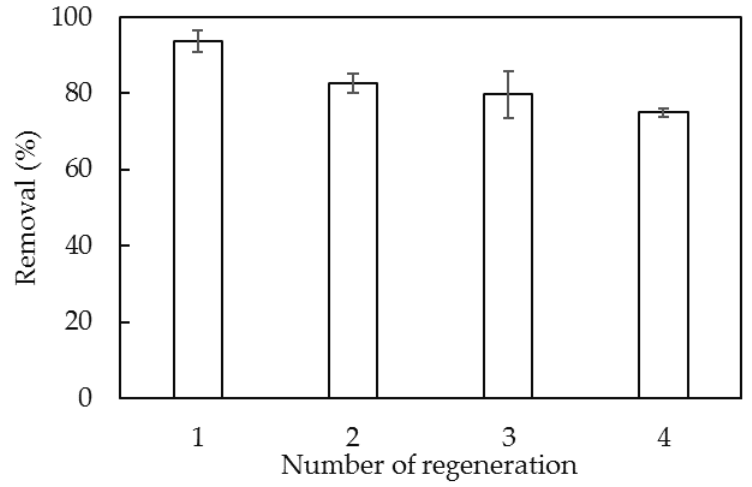
Figure 14. Removal efficiency of lindane using SMNAH after three regenerations. Error bars show standard deviation of three replicates.